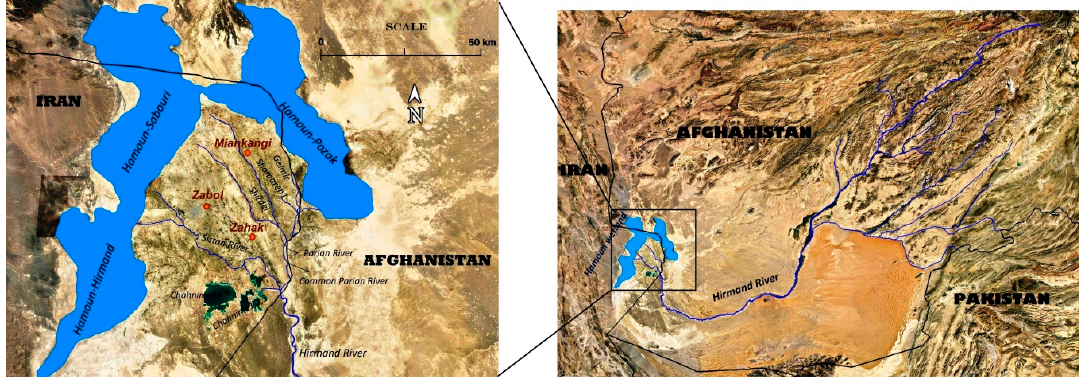
Figure 1. Hamoun wetland located in Sistan and Balouchestan province, Iran (Google Earth Pro 7.3.2.5491. (31 December 2016). https://earth.google.com/web).